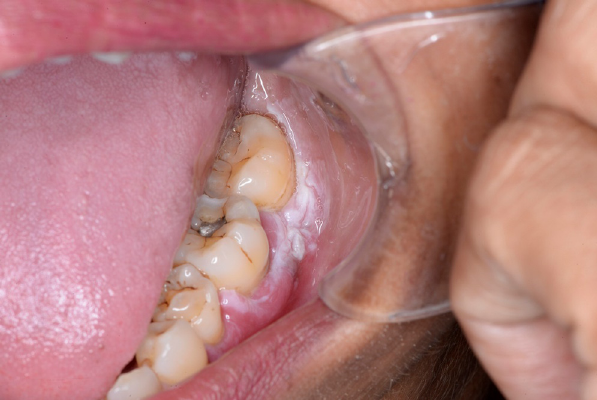
Fig. 2. Nodular leukoplakia involving the LL6/7 buccal gingivae (moderate dysplasia detected on histopathology) (image provided by Guy ’ s and St Thomas ’